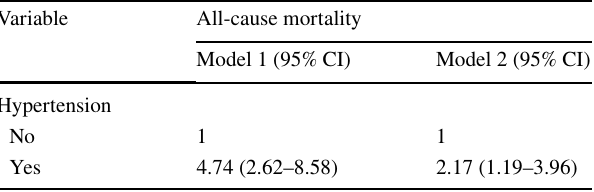
Table 2 The association between hypertension and all-cause mortal- ity